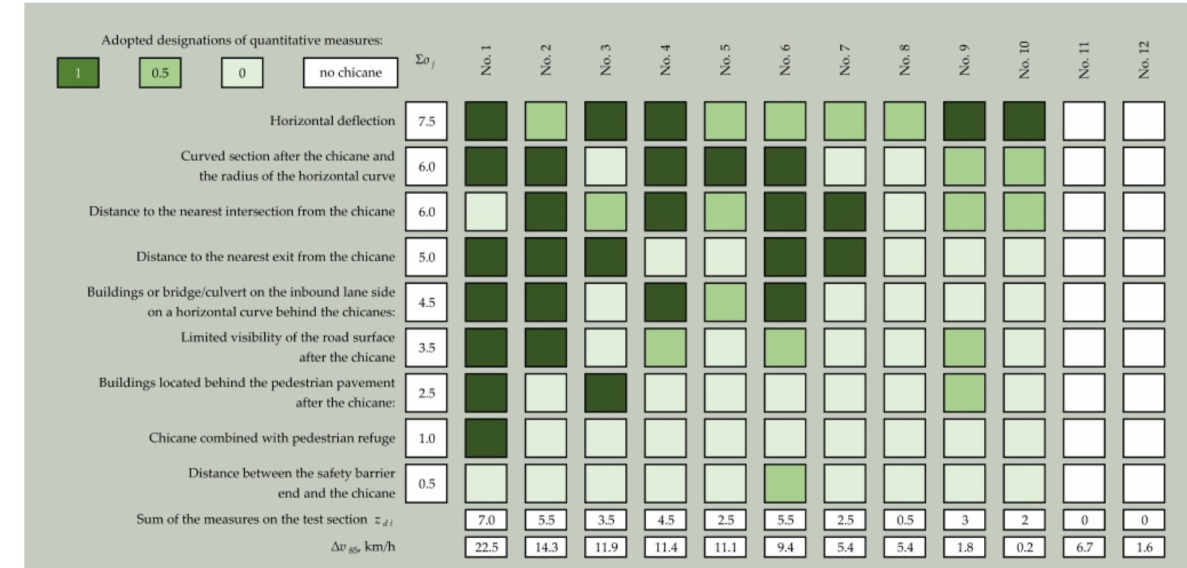
Figure 12. Outcomes of the assessment of the factors associated with the road design parameters criterion. Where: o j is a subsequent factor under consideration , Σ o j is the sum of confirmed logical tautologies on the test sections in relation to the considered j -th factor , and z d i is the sum of quantitative measures in all factors on the i -th test